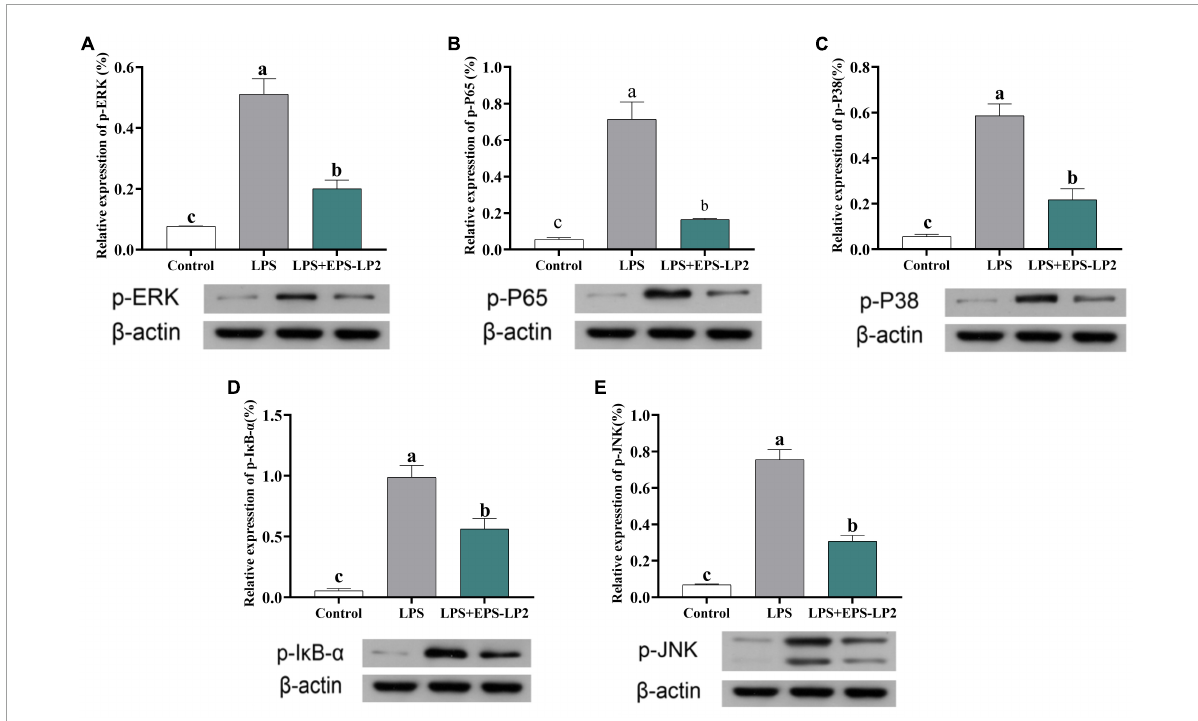
FIGURE6 Effects of exopolysaccharides (EPS)-LP2 on the MAPK pathway (A–C) in RAW 264.7 cells; effects of EPS-LP2 on the NF- κ B pathway (D,E) in RAW 264.7 cells. Different letters represent different significance from the control group ( p < 0.05).